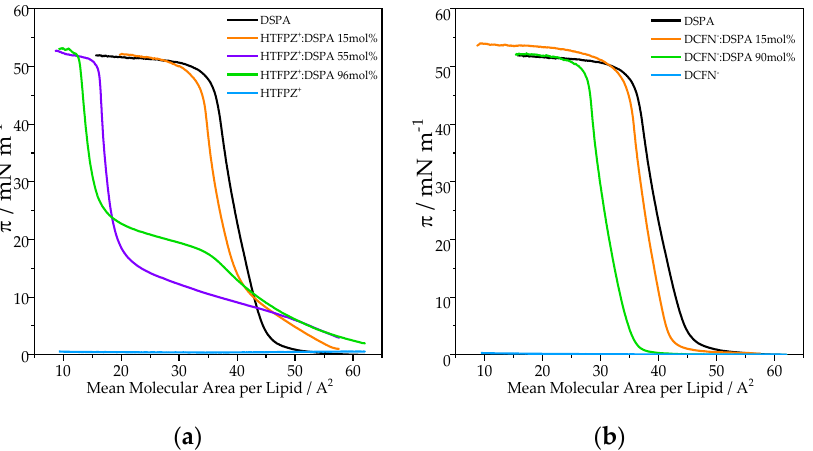
Figure 1. Surface pressure as a function of mean molecular area per lipid for the mixtures: ( a ) HTFPZ + :DSPA and ( b ) DCFN − :DSPA. Subphase composition: LiCl 10 mM.